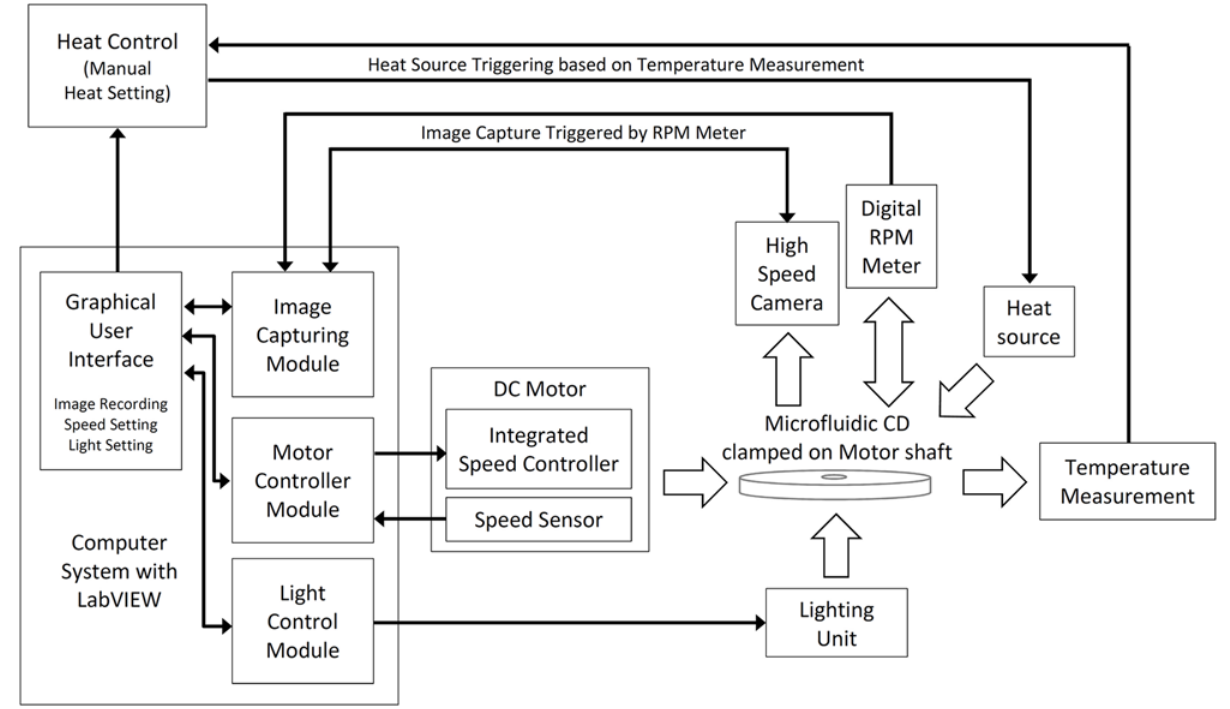
Fig 1. Schematic diagram of the CD spin test system. The custom made CD spin test system consists of a motorized spinning module, digital rpm meter, and high speed camera all controlled and monitored with a computer configured with LabVIEW. Forced convection heating and CD surface temperature measurement are performed using a modified industrial grade hot-air gun and infrared (IR) thermometer.